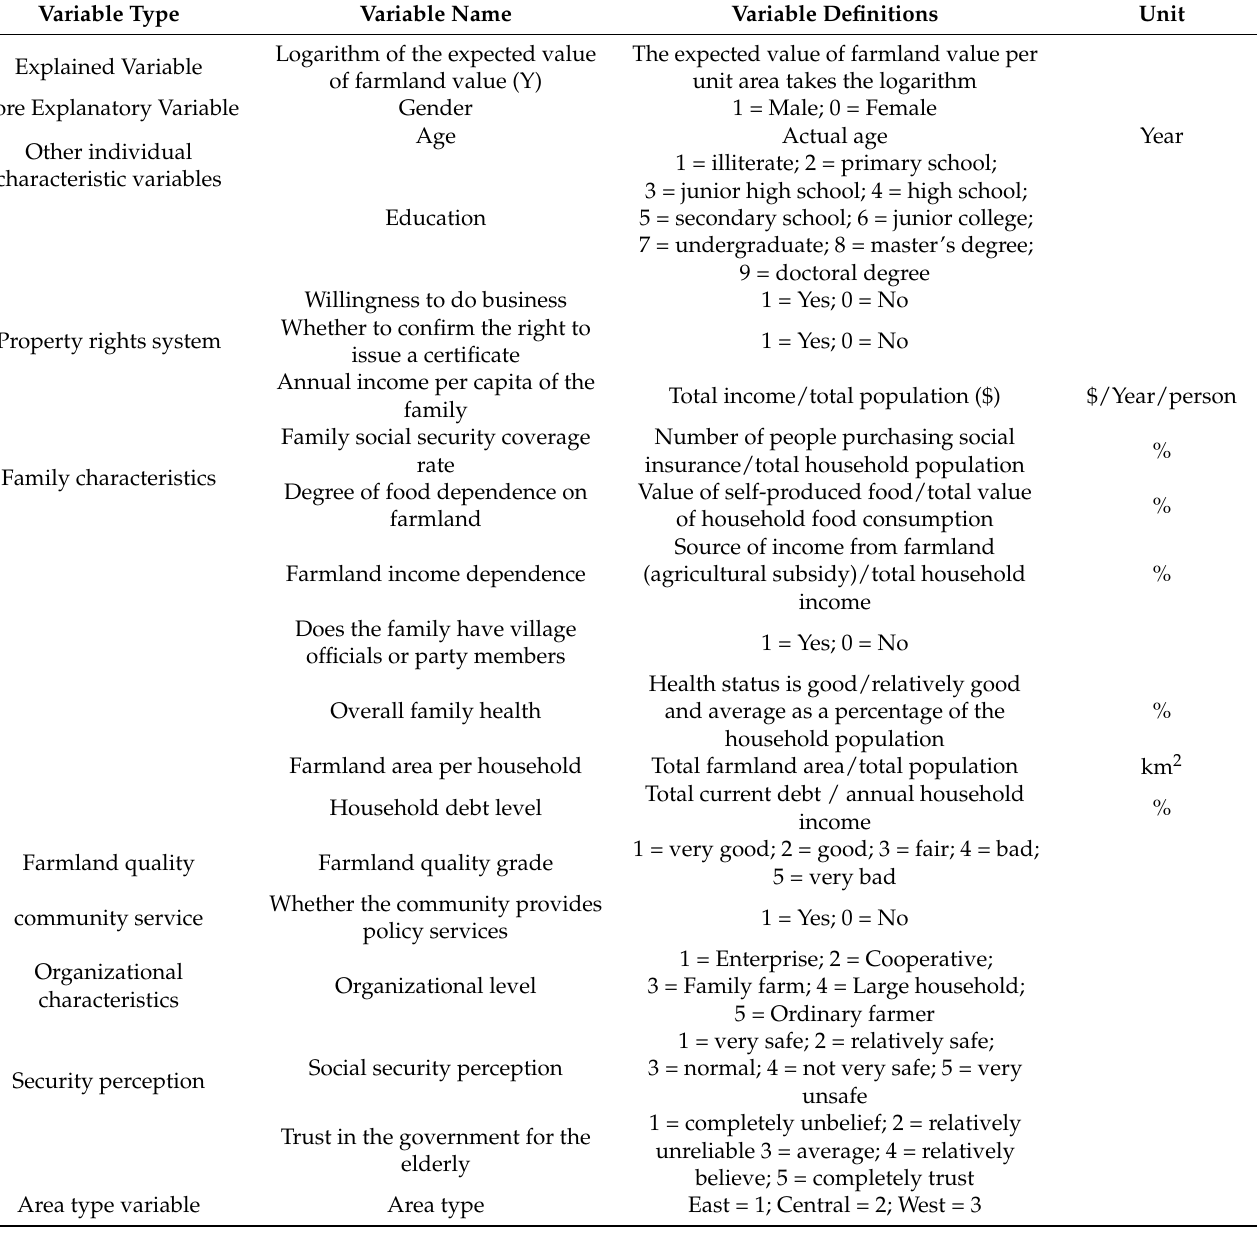
Table 1. Variable meanings and assignment